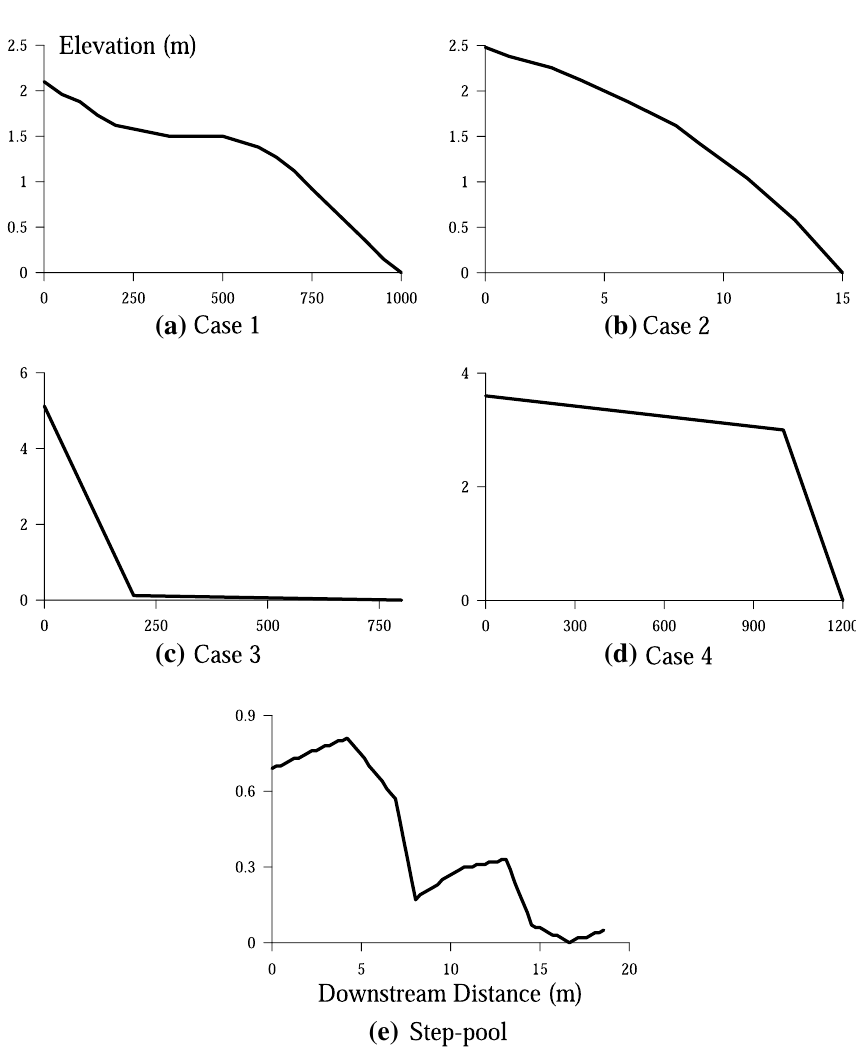
Fig. 1 Bed profile for different